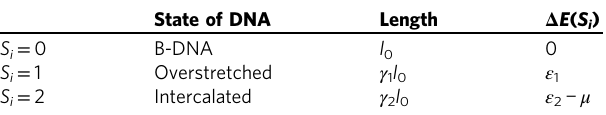
Table 1 An overview of the three states S i = 0, 1, 2 of link i = 1, ..., N of our model DNA, with their interpretation, length measured in base pair distance in B-DNA, l 0 , and free energy penalty Δ E discussed in the Methods section